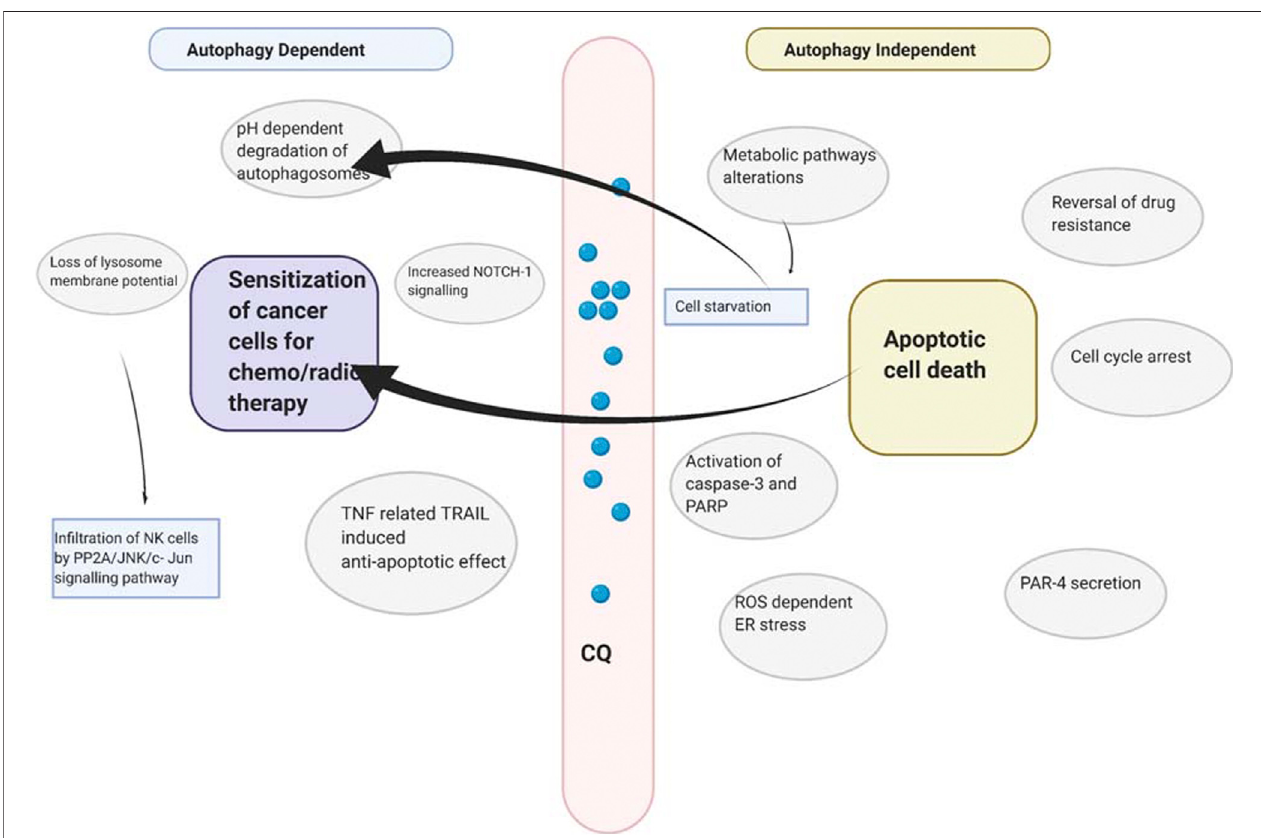
FIGURE 2 | Probable mechanism employed by chloroquine to kill cancer